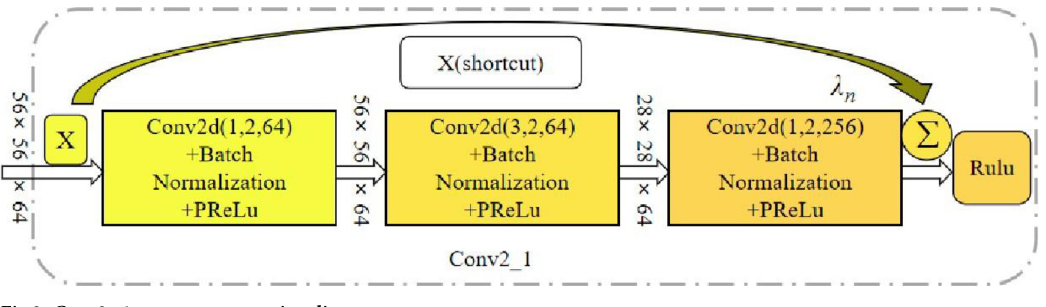
Fig 3. Conv2_ 1 parameter operation